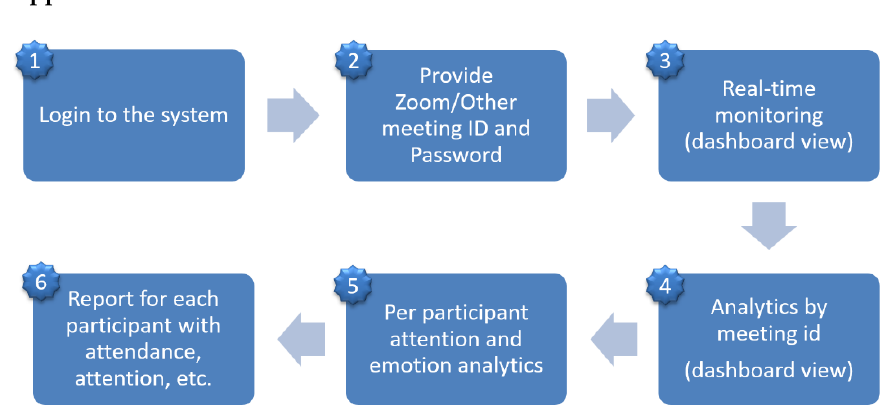
Figure A2. User journey of proposed system (automated system implementation).